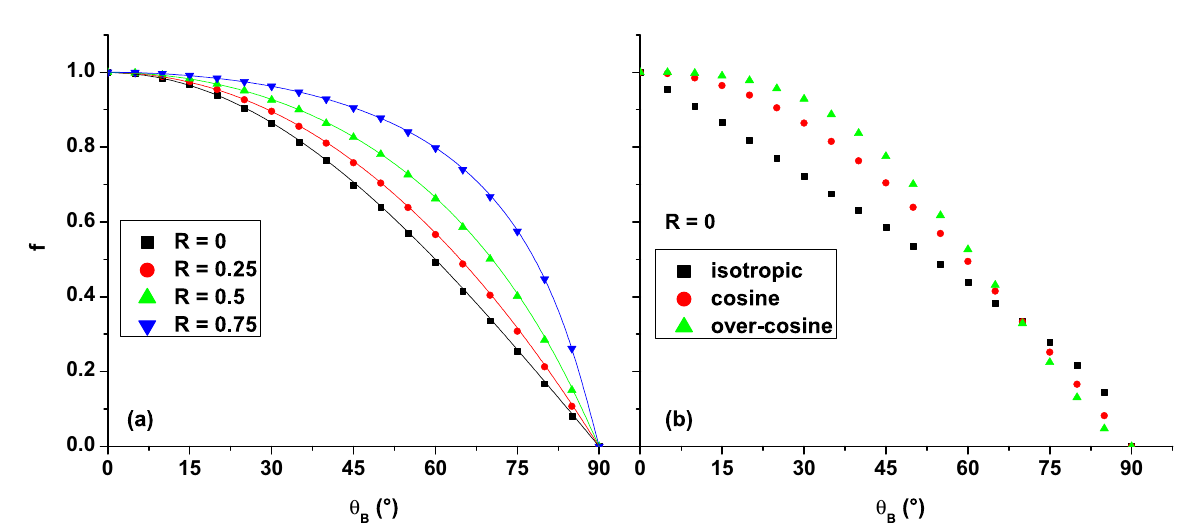
Figure 3. Dependence of the relative SEY on the magnetic field angle θ B , in the absence of an electric field: ( a ) secondary electrons with cosine angular distribution and different values of the reflection coefficient R ; ( b ) secondary electrons with different angular distributions and R lines in ( a ) correspond to Eq.